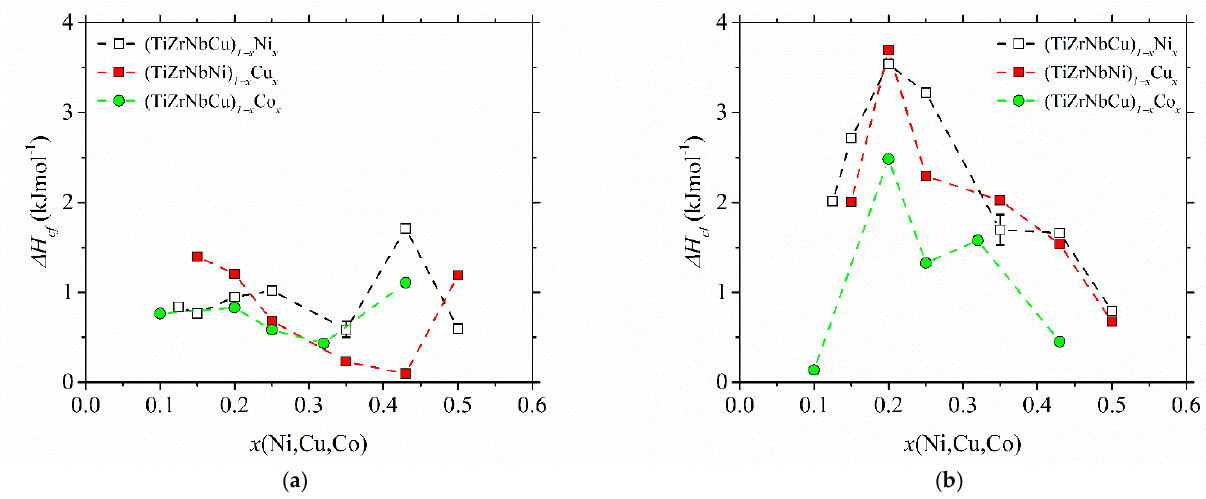
Figure 8. Crystallization enthalpies of (TiZrNbNi) 1 − x Cu x , (TiZrNbCu) 1 − x Ni x and (TiZrNbNi) 1 − x Co x alloys vs. x : ( a ) corresponding to the first crystallization event, ∆ H cf , and ( b ) corresponding to the last crystallization event, ∆ H cl .